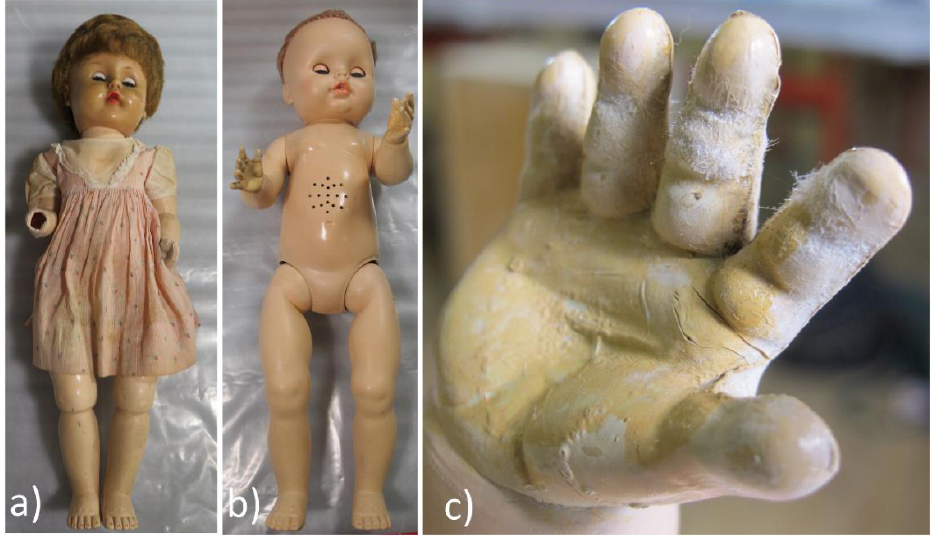
Figure 4. Degradation of CA dolls: ( a ) doll K2 with a yellowed and degraded PVC head; ( b ) doll C13; ( c ) detail of the hand of doll C13 with needle-shaped crystalline efflorescence. Image © Tate.